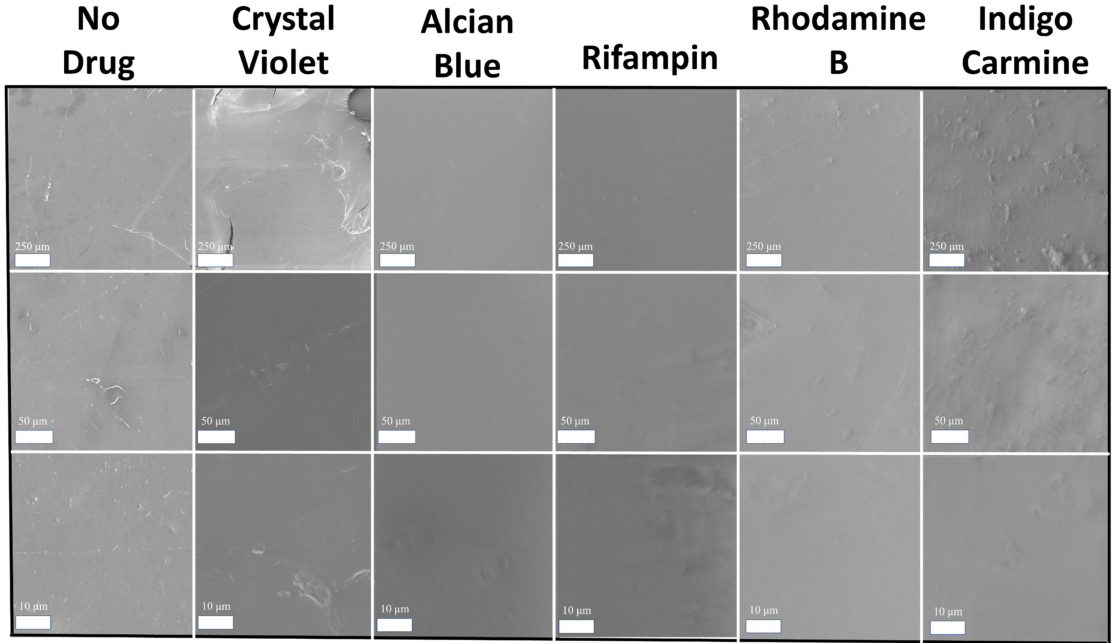
Figure 8. SEM images of silk-model drug thin films. Scale bars from top to bottom row: 250 µ m, 50 µ m, 10 µ